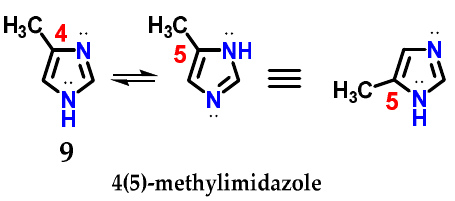
Figure 6. Representation of the tautomeric forms of methyl imidazole 9 .